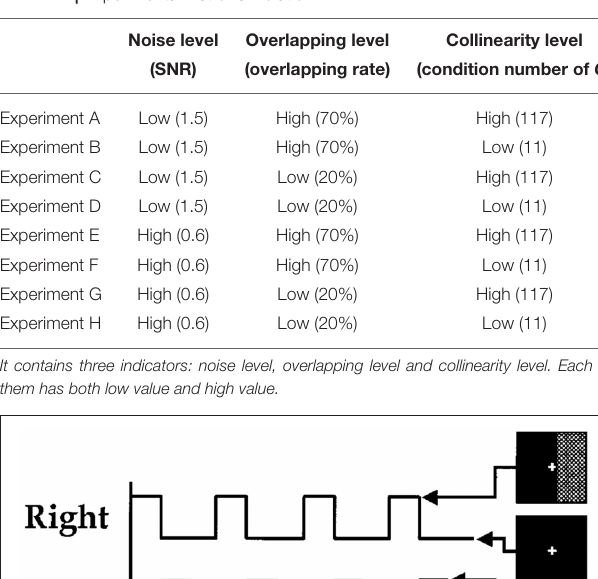
TABLE 1 | Experimental List of Simulation.